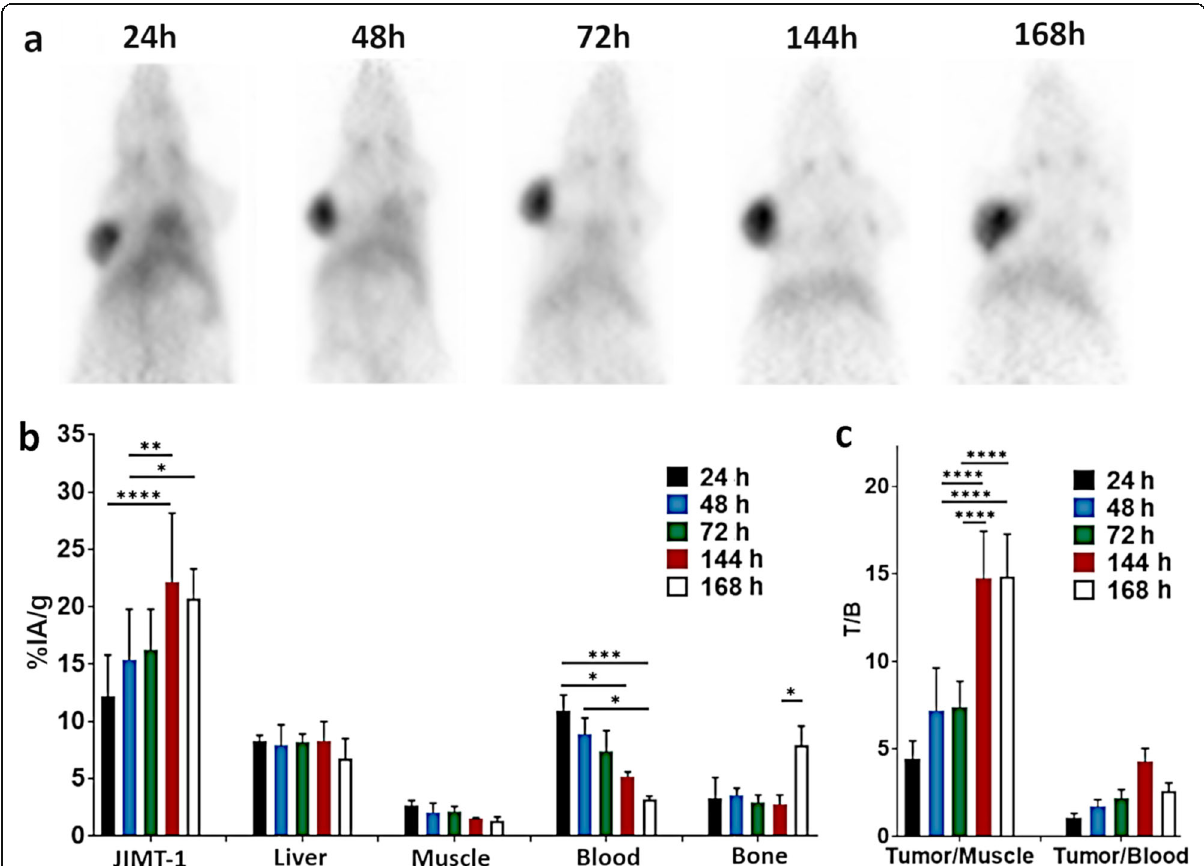
Fig. 1 Longitudinal PET imaging following 89 Zr-T injection in subcutaneously implanted HER2+/ER − JIMT-1 bearing mice. a Representative maximum intensity projection (MIP) images of the same mouse imaged at 24, 48, 72, 144, and 168 h post-injection of 89 Zr-T. Images are all scaled at the same saturation level (0 to 15 %IA/g). b PET-derived 89 Zr-T uptake in %IA/g of assessable tissues from 24 to 168 h post-injection. Blood uptake was estimated from signals originating from the heart cavity. c Tumor-to-muscle and tumor-to-blood ratios at all assessed time points. * p < 0.05; ** p < 0.01; *** p < 0.005; **** p <